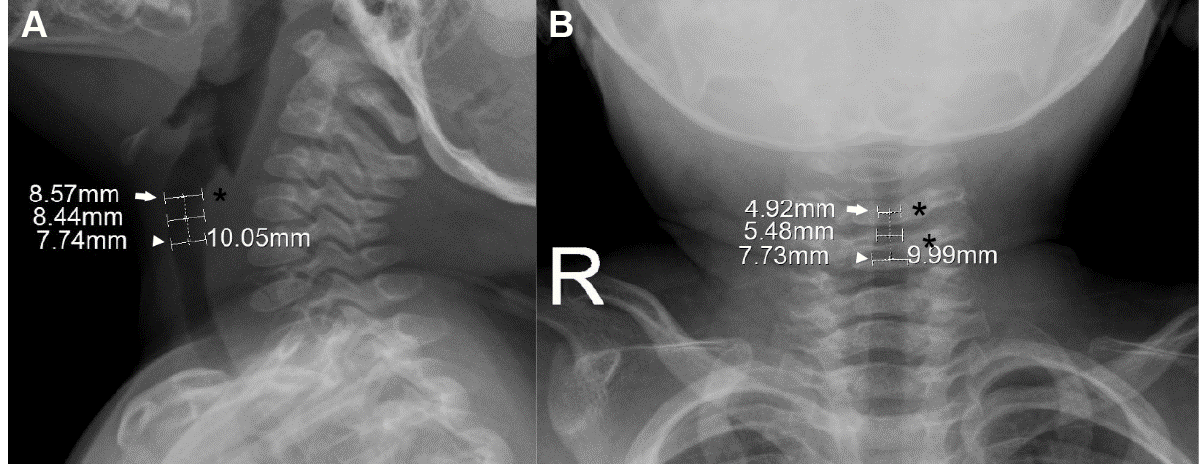
Figure 1. Measurement of laryngeal dimensions in a 15-month-old boy. On the lateral view ( A ), the glottis (arrow), which was extrapolated from computed tomography-based localization (see Figure S1), is further pointed out by the most protuberant portion of the posterior wall of the hypopharynx (asterisk). On the anteroposterior view ( B ), the glottis (arrow) is further specified as the narrowest level around the third and fourth cervical vertebrae (asterisks). The cricoid (arrowheads) was defined at a level 10.0 mm caudal to the glottis along the long axis (dotted lines). The subglottis was defined as the midpoint between the two levels. The measured anteroposterior ( A ) and transverse ( B ) diameters are noted at each level.